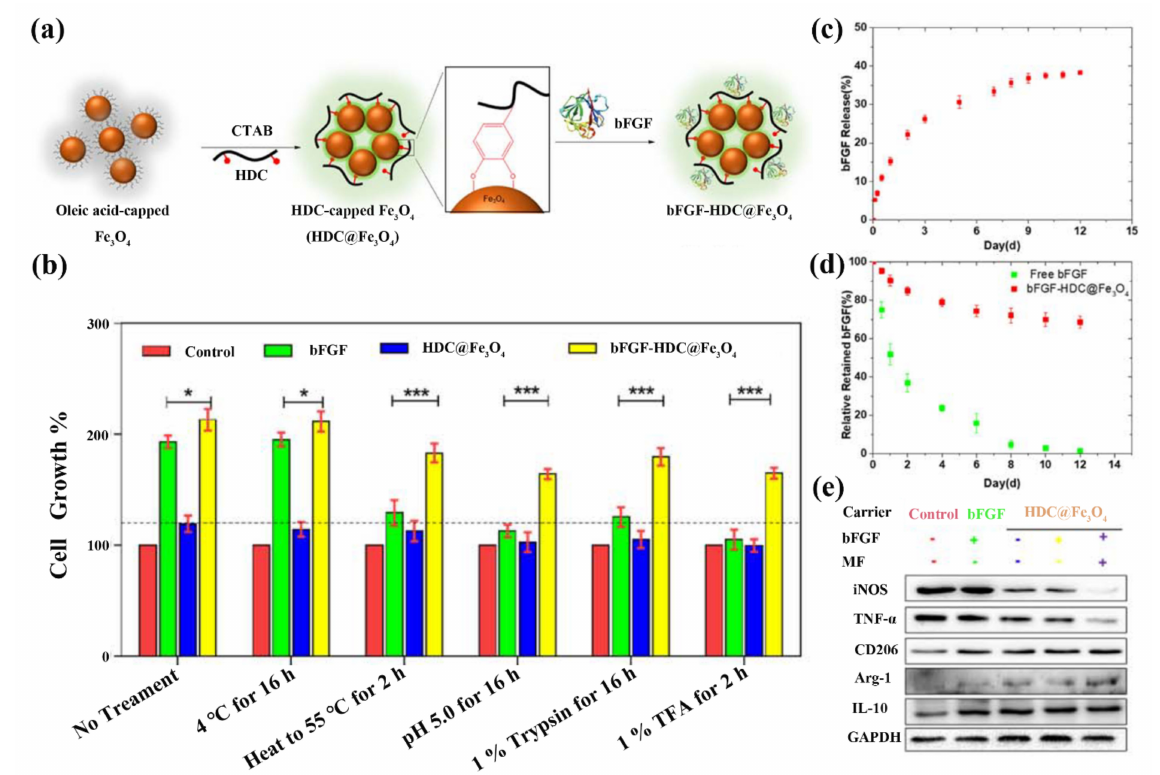
Figure 1. ( a ) Diagrammatic sketch of bFGF-HDC@Fe 3 O 4 fabrication; ( b ) cell growth rate of NIH 3T3 cultures in groups of free bFGF, HDC@Fe 3 O 4 , and bFGF-HDC@Fe 3 O 4 exposed to various conditions, for statistical significance, * p < 0.05 and *** p < 0.001; ( c ) bFGF release behavior of bFGF- HDC@Fe 3 O 4 ; ( d ) bFGF bioactivity evaluation of bFGF-HDC@Fe 3 O 4 (red) and free bFGF (green); ( e ) expression analysis of proinflammatory macrophage-associated proteins (iNOS and TNF- α ) and anti-inflammatory phenotype macrophage-associated proteins (CD206, Arg-1, and IL-10) through Western blot. CTAB, hexadecyl trimethyl ammonium bromide; HDC, dopamine heparin conjugate; factor; TFA, trifluoroacetic acid. Adapted with permission from [25], published by the American Chemical Society,